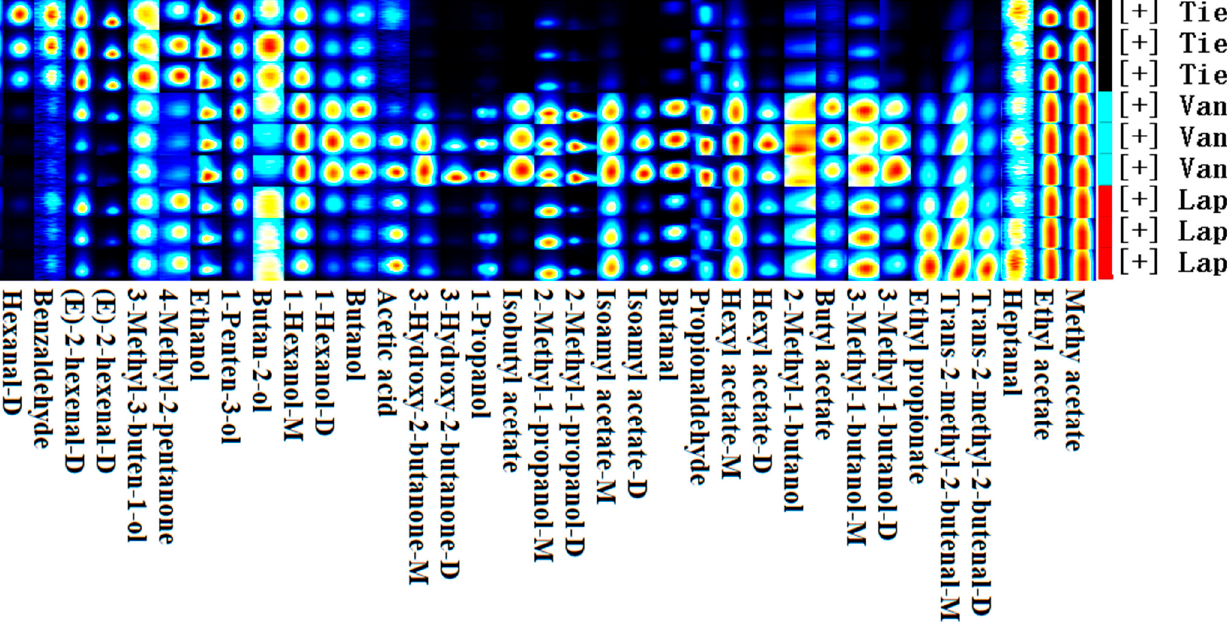
Figure 3. The Gallery Plot of volatile compounds in cherry fruits from three